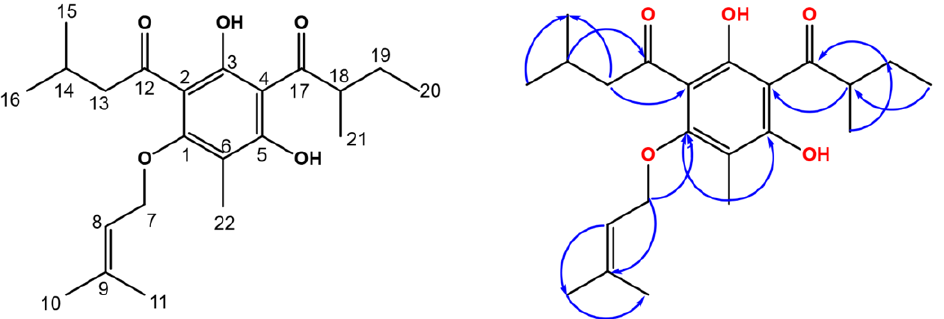
Figure 2. Chemical structure of compound 1 and some HMBC correlations. Table 1. NMR spectral data of compound 1 (CDCl 3 , 850 and 214 Hz).